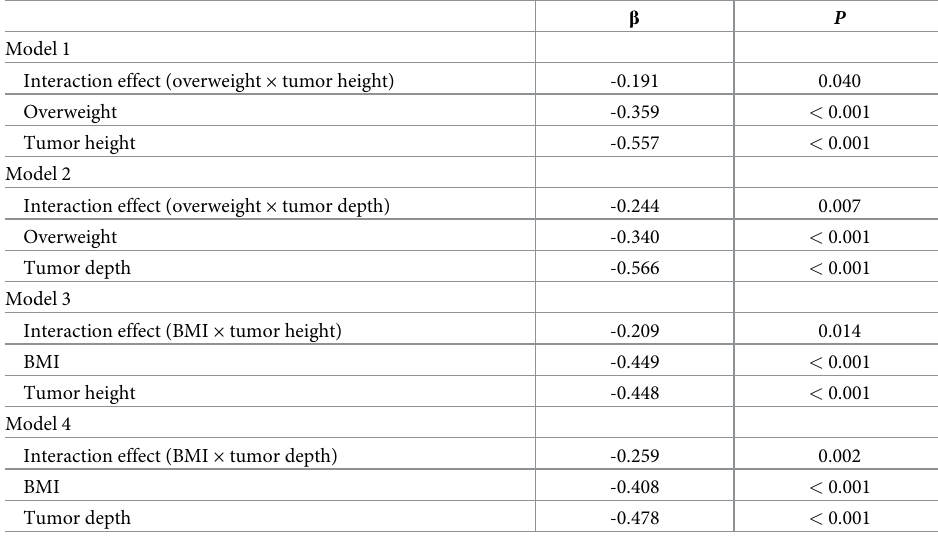
Table 4. Multiple regression analyses with peak GH response to GHRP-2.